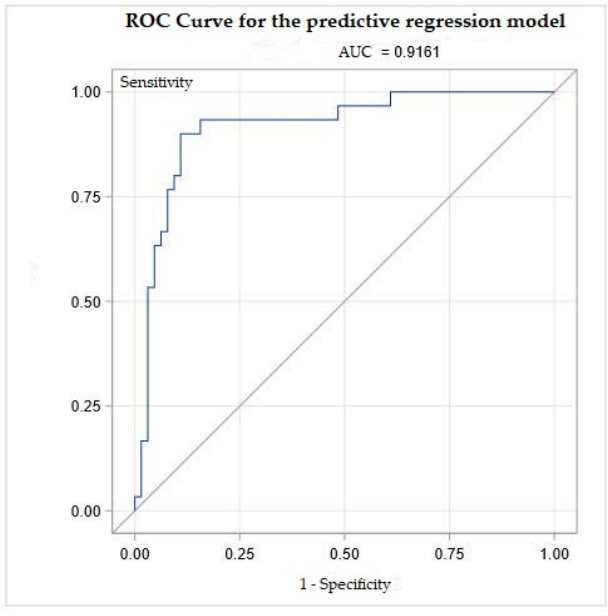
Figure 3. ROC Curve for the predictive regression model. The most predictive variables are LUSt0 (OR 1.1; IQR 1.0 − 1.3), age (OR 1.1; IQR 1.0 − 1.2), sex (OR 0.7; IQR 0.2 − 3.6), and days in spontaneous breath (OR 0.2; IQR 0.1 − 0.5) predict the risk of death for COVID-19 patients. AUC = Area Under the Curve.